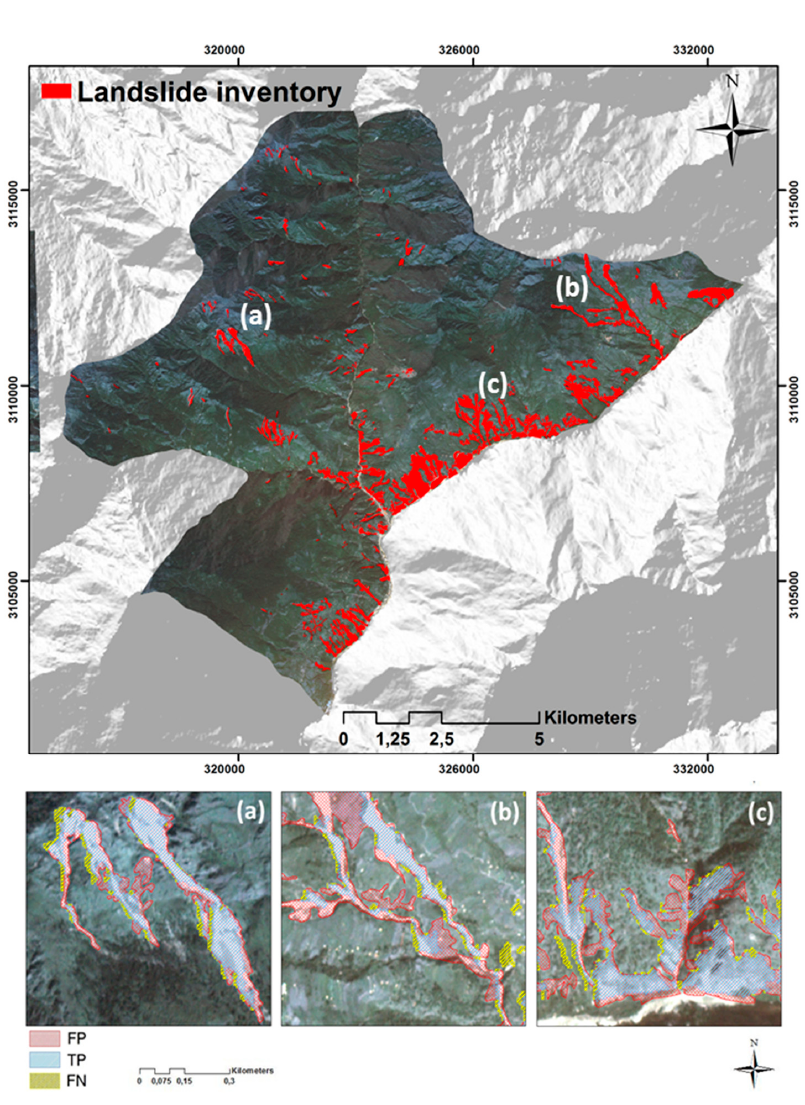
Figure 9. Inventory map with GPS-measured landslide polygons optimized by manual detection and correction using RapidEye satellite images (upper raw). The three sample areas of a, b and, c in the lower raw illustrate true positives (TP), false positives (FP) and false negatives (FN).